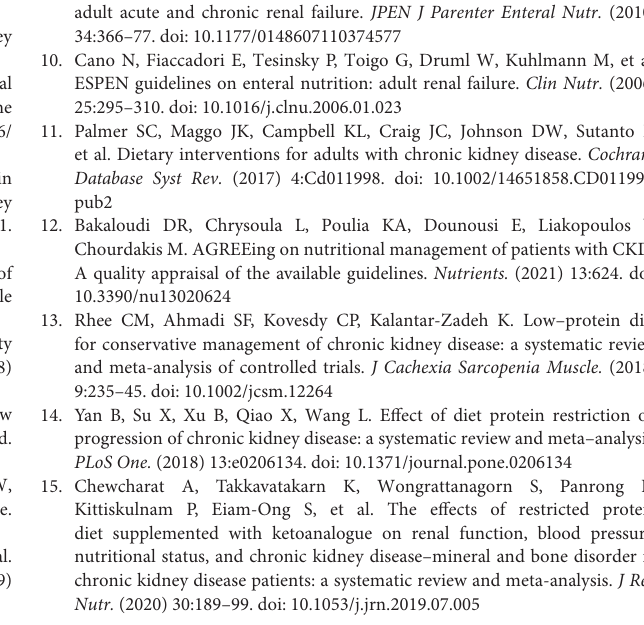
Supplementary Figure 1 | Flow chart of the study